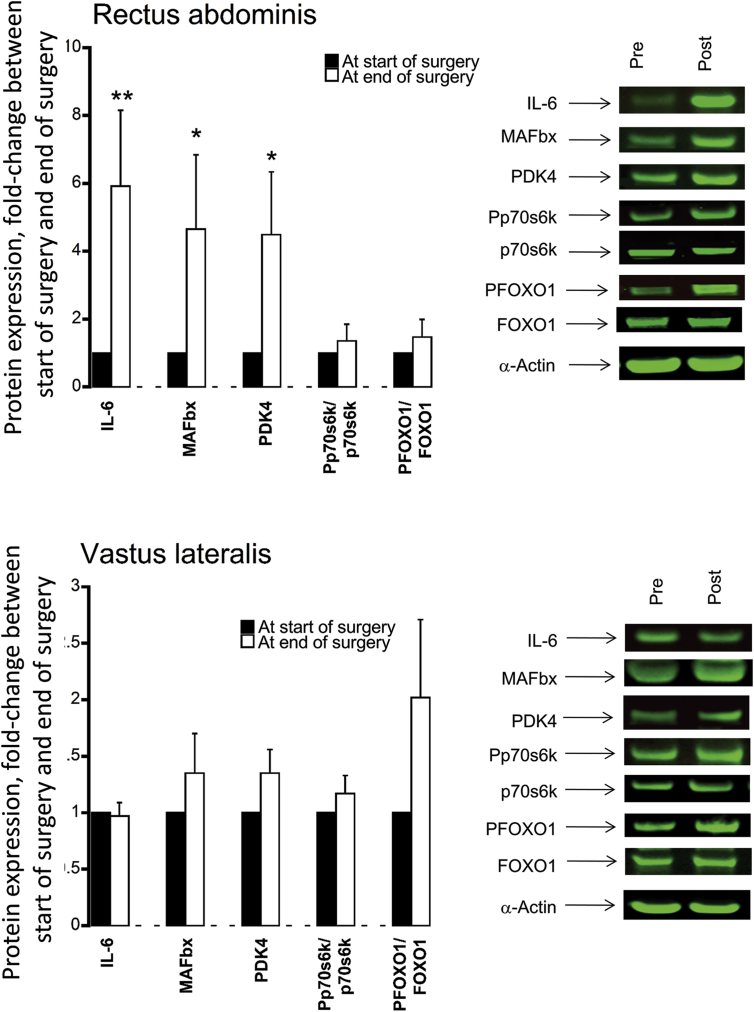
Relative protein expression levels of IL-6, MAFbx, PDK4, the ratio of Pp70S6K/p70S6K and the ratio of PFOXO1/FOXO1 in (top) rectus abdominis muscle (local to the site of surgery) and (bottom) vastus lateralis muscle (distant from the site of surgery) obtained at the start of surgery and immediately after surgery from participants undergoing major abdominal surgery (n = 15). Values are expressed as fold change from the value at the start of surgery. *P < 0.05, **P < 0.01 significantly different from the value at the start of surgery (set at 1).